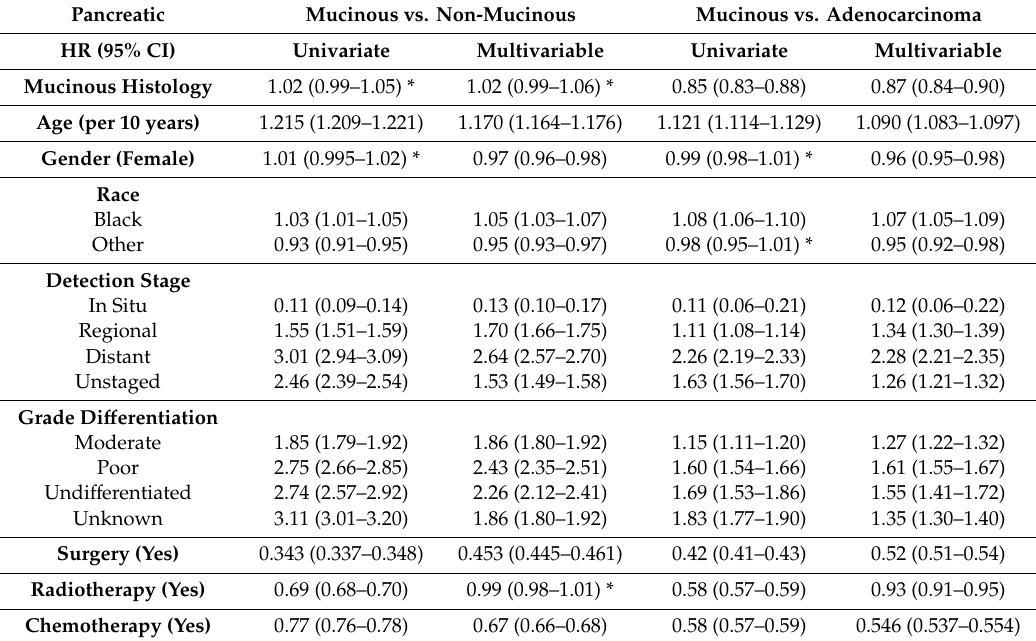
Table 10. Derived univariate and multivariable Cox-proportional hazard ratios (HR) of mortality for pancreatic cancers.